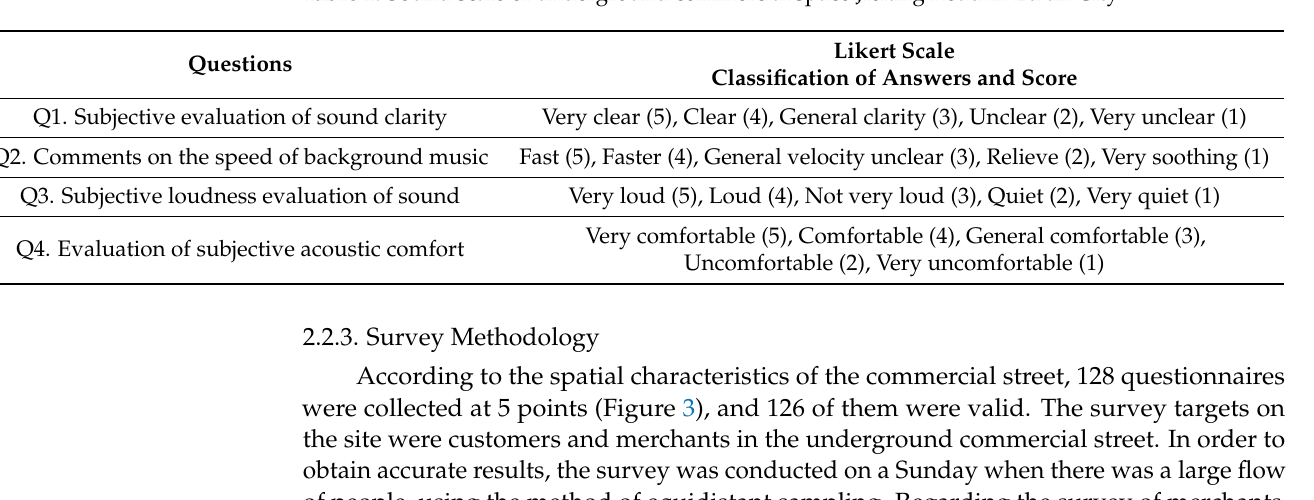
Figure 5. Basic composition of interviewees in underground commercial space on Jiefang Road in Lu’an City. Table 1. Sound scale of underground commercial space Jiefang Road in Lu’an